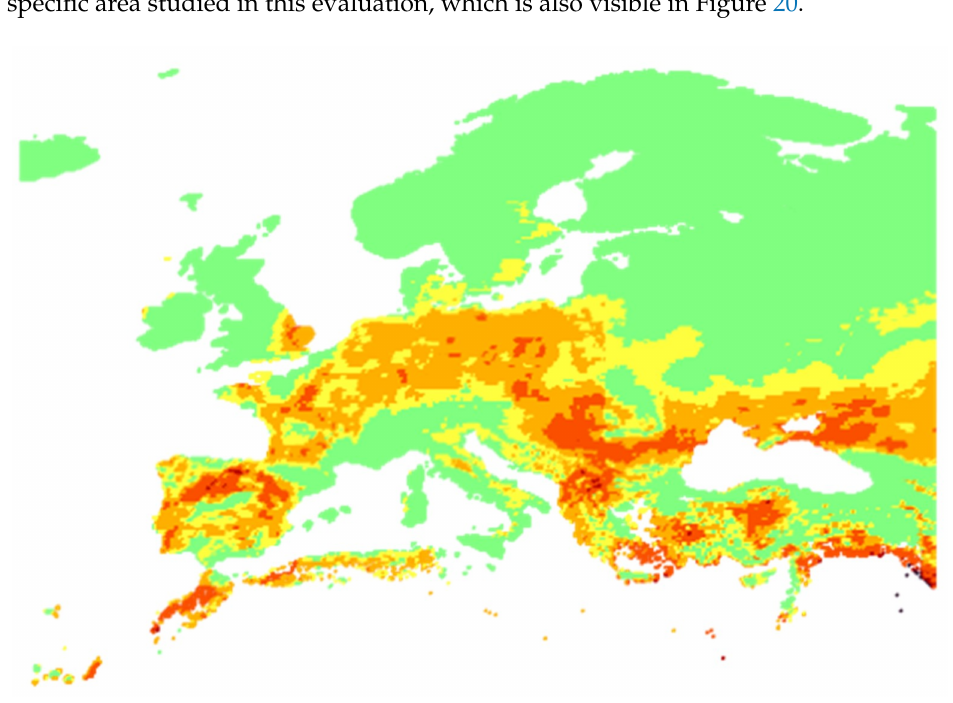
Figure 20. The fire alert levels embedded with different colors on a GeoTIFF raster image provided by EFFIS service for 23/7/2018 across